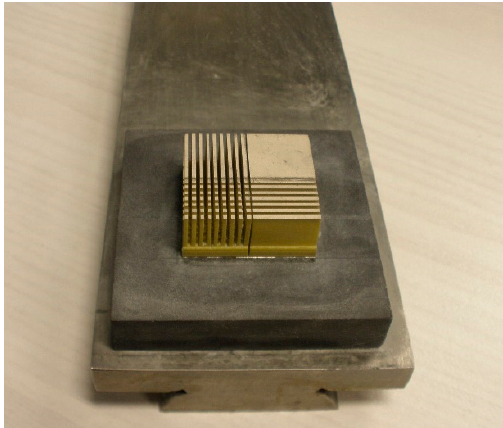
Figure 2. Grooved PZT block.